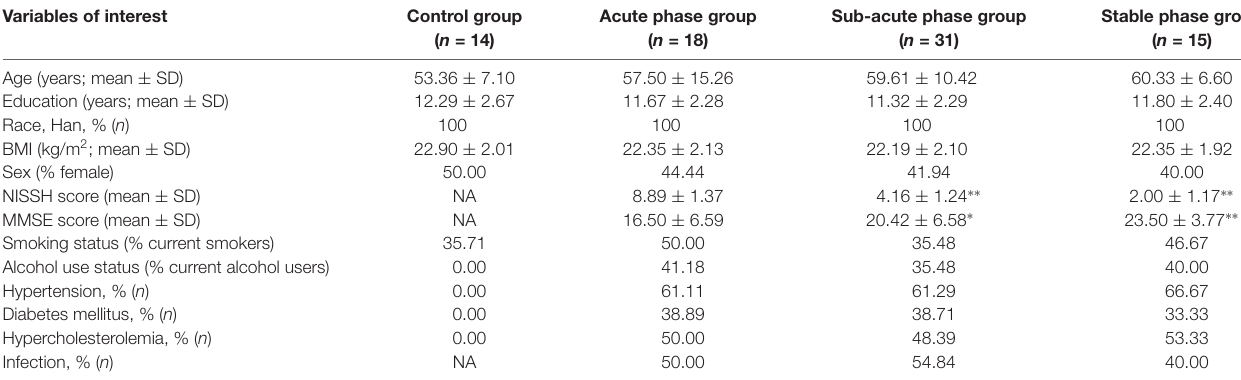
TABLE 1 | Demographics and baseline characteristics.